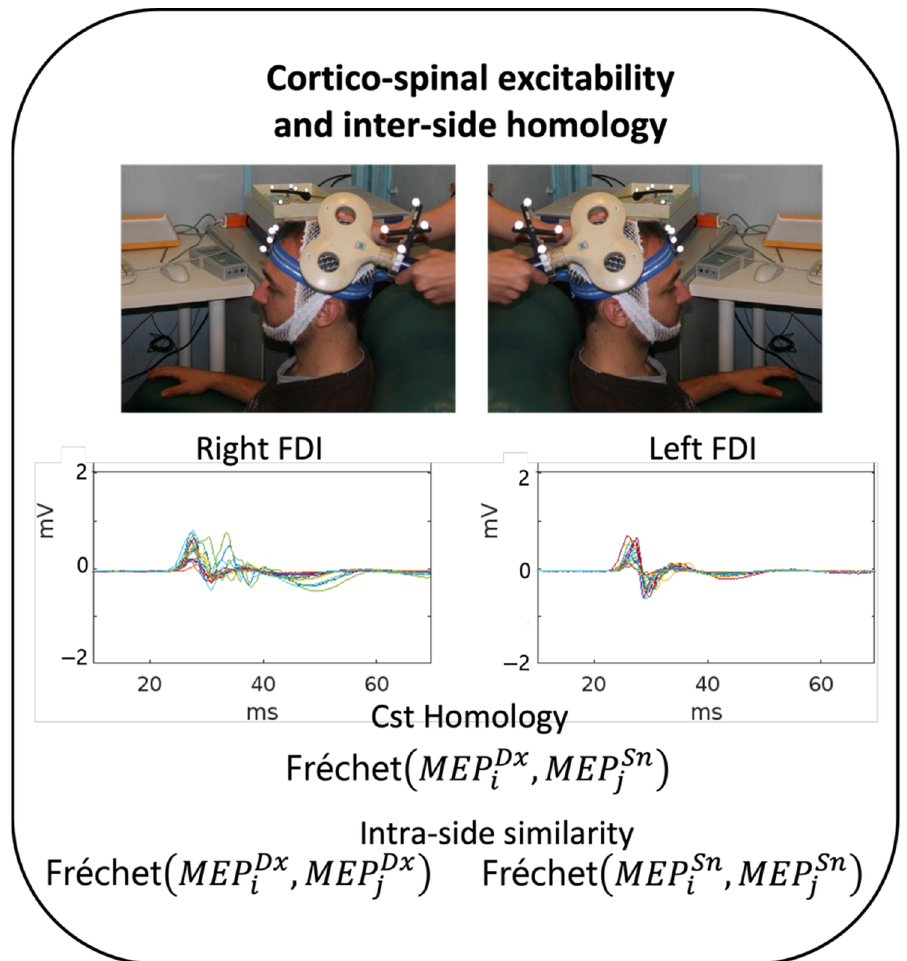
Figure 1. Experimental setting. Experimental procedure in each healthy volunteer (HV). Top: In each hemisphere, once the TMS FDI hotspot was identified, the position of the coil was monitored using a neuronavigational system. Approximately 20 MEPs were collected from each side, shown here superimposed in the 0–70 ms window of a representative HV. Bottom: CST homology was estimated as Fréchet distances between each pair of left and right MEP (homologous) morphologies (400 values in each subject) and between each pair of MEPs from the same side (190 values for each subject and each side).